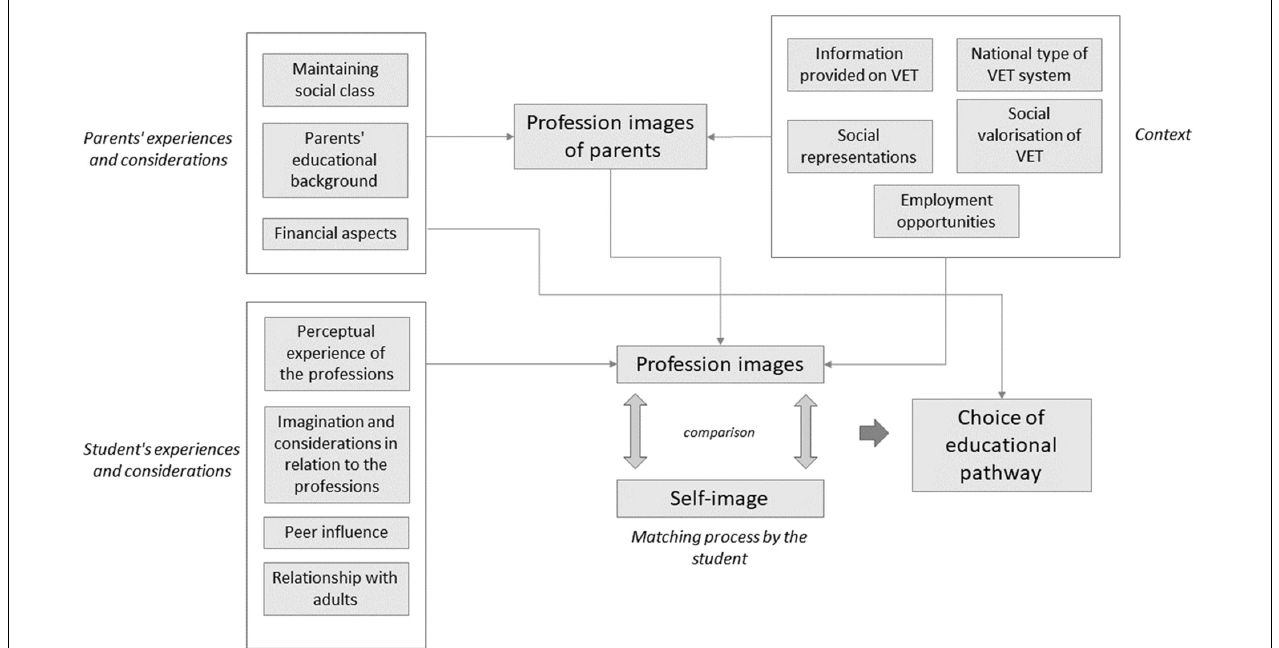
FIGURE 6 | Integrated model of the educational and vocational